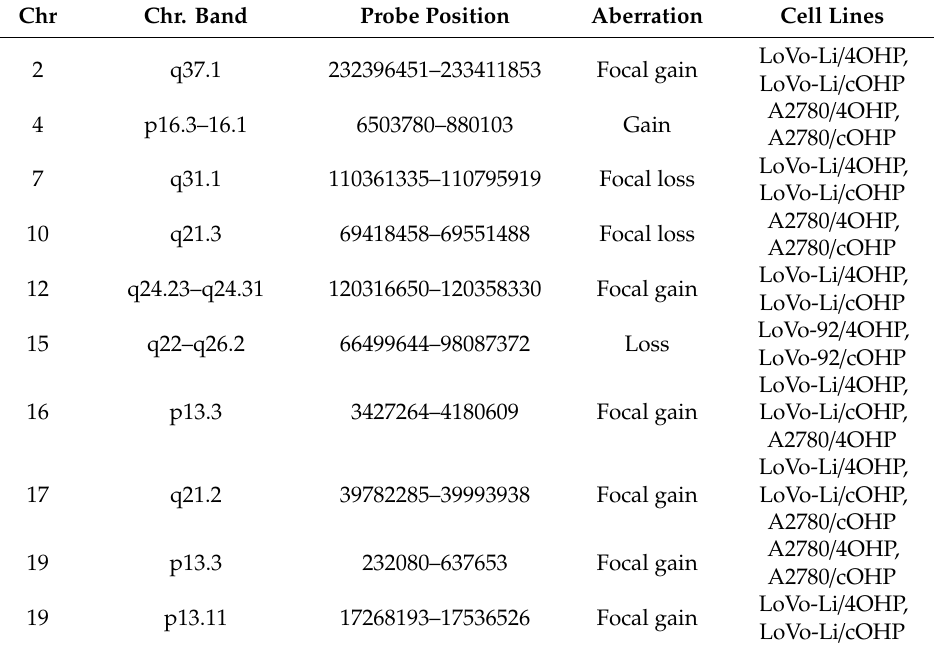
Table 5. Common or overlapping chromosomal